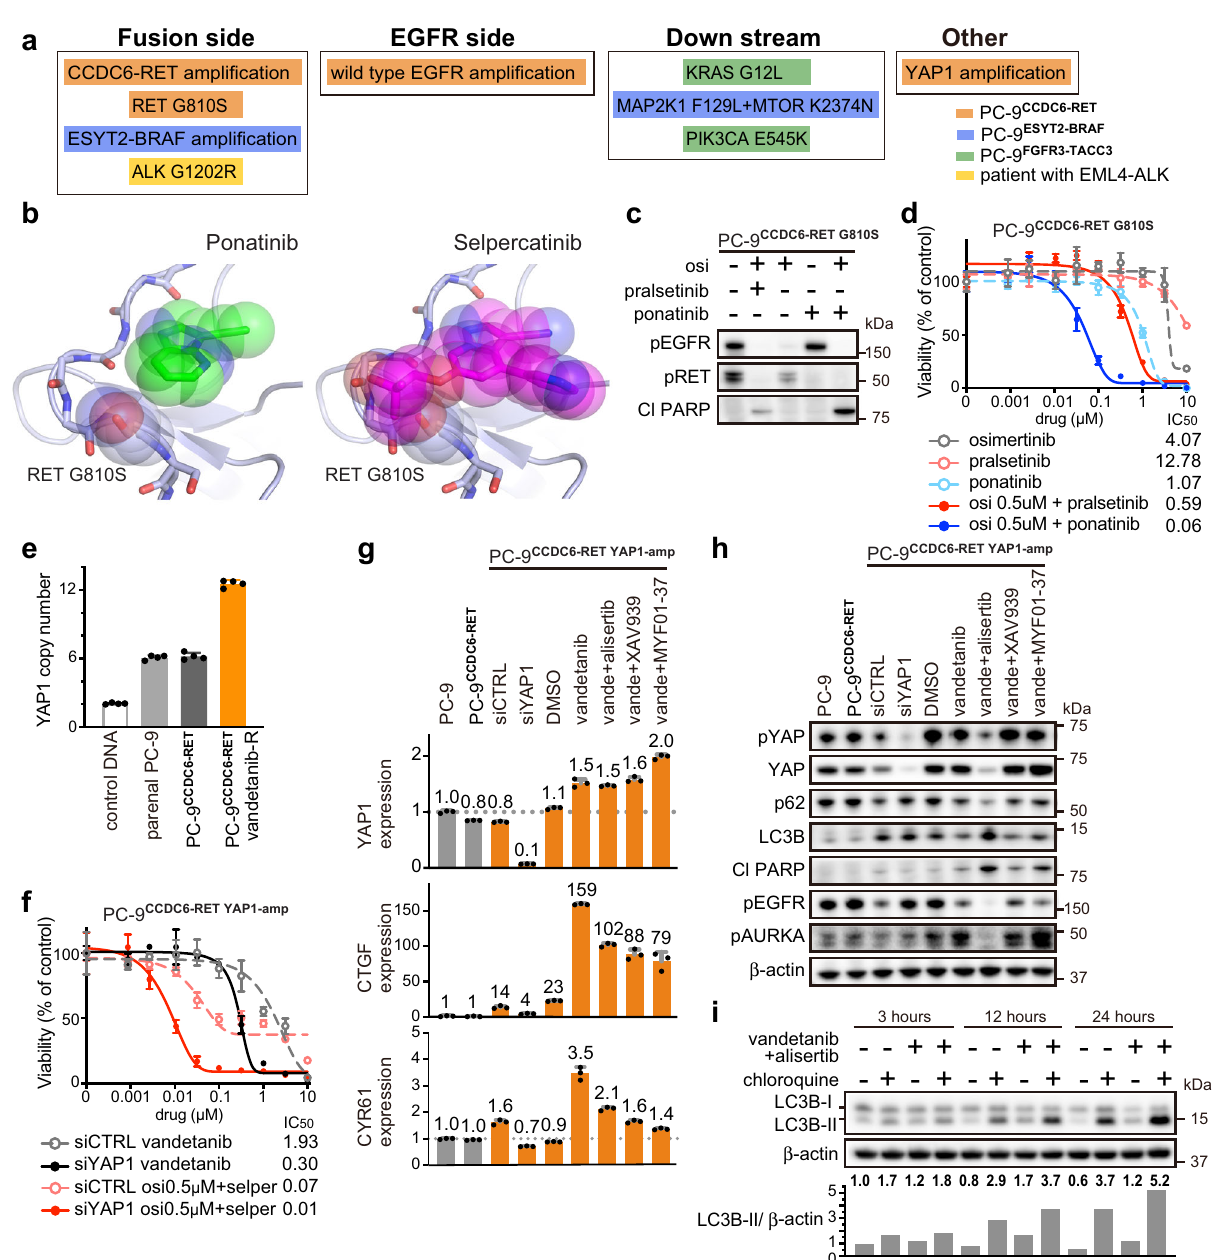
Fig. 7| Mechanismsofacquiredresistancetocombinationtherapyinapatient and in in vitro models. a Summary of mechanisms of acquired resistance to inhibitionof EGFR andfusiongenesinapatient,aswellasinCRISPR-modi fi edPC-9 models. osi:osimertinib. b Crystalstructureof RET in a complex with ponatinib or selpercatinib. Modeling the G810S mutation shows the resulting clashes with sel- percatinib, but not with ponatinib. c Western blot analyses following 48h of treatment with 0.5 μ M of the indicated drugs in PC-9 CCDC6-RET models that had acquired RET G810Smutation, after being exposed to osimertinibplus pralsetinib. d Cell viability assay after 72h of treatment of PC-9 model harboring RET G810S mutation( n =3biologicalreplicates,mean±s.d.). e Copynumberof YAP1 evaluated by quantitative PCR. RNaseP was used as an internal control ( n =4 biological